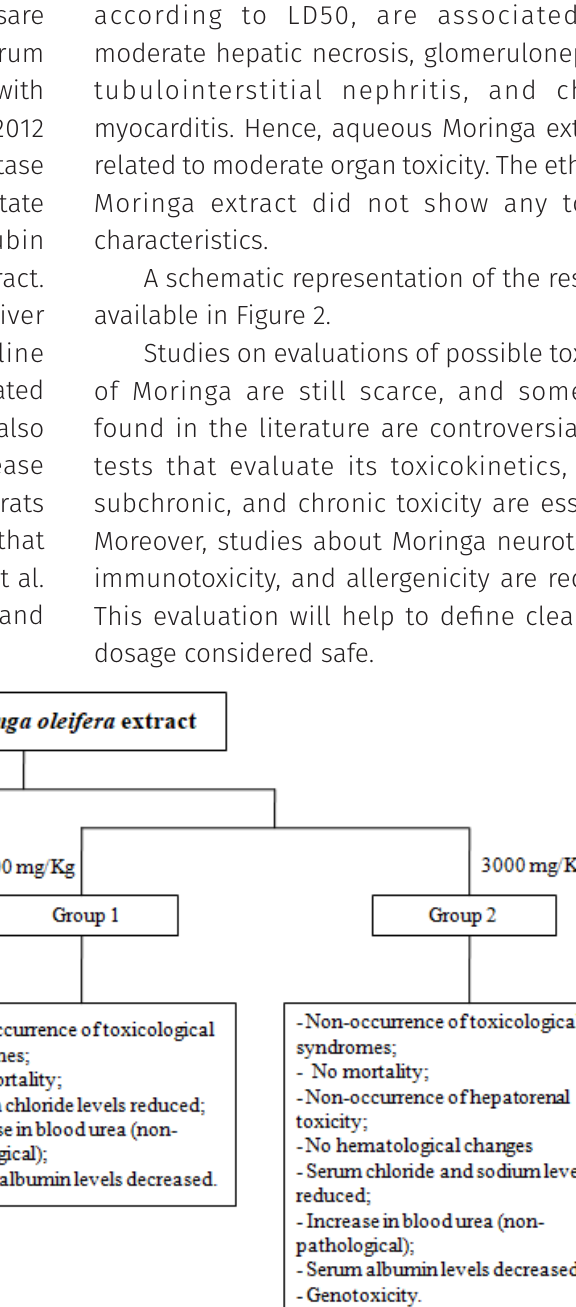
Figure 1. Schematic representation of data referring to the study carried out by Asare et al. 2012 on the toxicity of the aqueous Moringa oleifera leaves